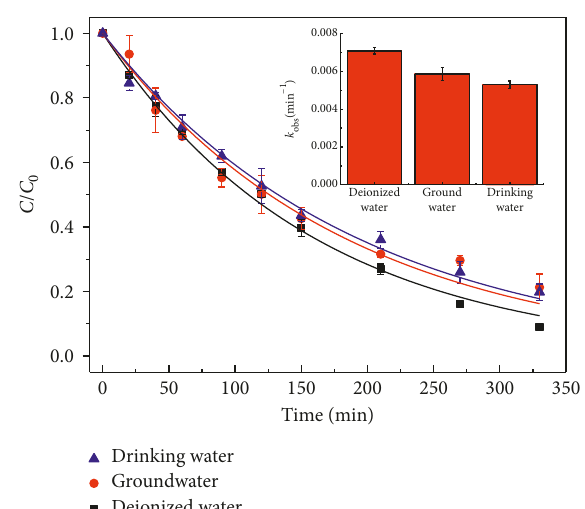
Figure 12: Effects of different real waters on AMO degradation by TAP. Solid lines represent the pseudo-first-order kinetic model fits. Insert: changes of k obs at different real waters. Experimental conditions: [AMO] 0 � 0.1mM; [PS] 0 � 10mM; T � 50 ° C; reaction time � 330min.